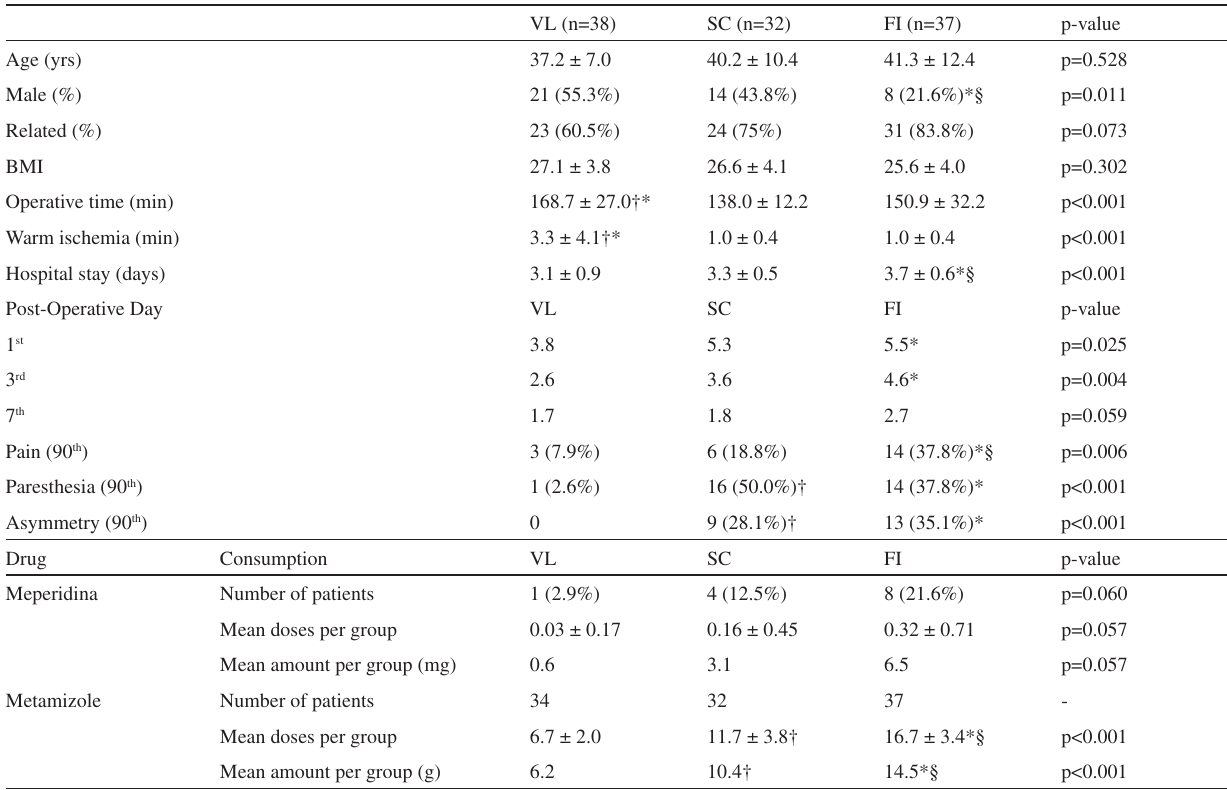
Table 1 - Donor demographics, pain scale, and analgesic use